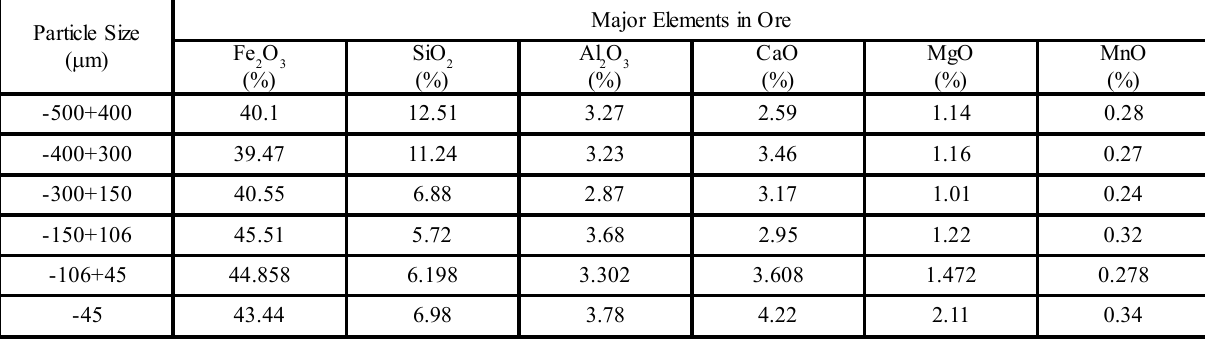
FIG. 3(e). SEM-EDS SPECTRA AND GRADE OF- 75+45  m FIG. 3. SEM IMAGES WITH EDS SPECTRA OF VARIOUS SIZE FRACTIONS OF ZARD KOH TABLE 2. XRF ANALYSIS OF VARIOUS PARTICLE SIZES OF KULLI KOH ORE